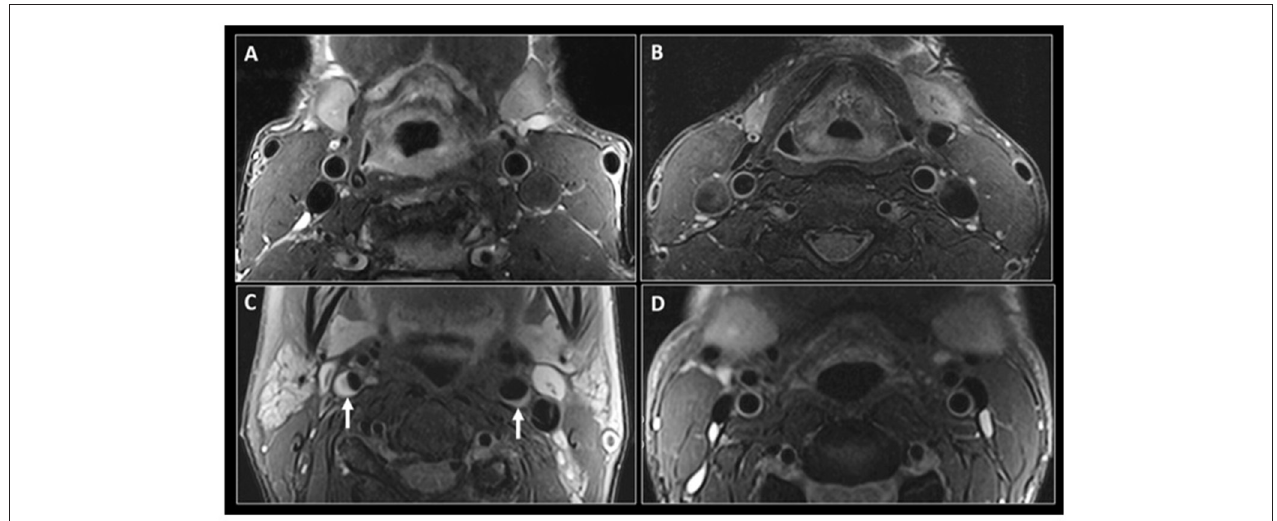
FIGURE 2 | Black-blood MR imaging of the carotid arteries. Adapted from “Subclinical atherosclerosis imaging in people living with HIV,” by I. C. Schoepf, R. R. Buechel, H. Kovari, D. A. Hammoud and P. E. Tarr, 2019, Journal of clinical medicine , 8(8), p. 1125 (https://www.mdpi.com/2077-0383/8/8/1125). CC BY. Fat saturated T2-weighted black-blood MR images at the level of the common carotid arteries in a 56-year-old HIV-positive man (A) and a 47-year-old HIV-negative man (B) . Similar imaging technique at the level of the internal carotid arteries in a 56-year-old HIV-positive woman (C) shows narrowing of the vascular lumen bilaterally by a plaque (small arrows), more significant on the right side. (D) shows similar imaging at the level of internal carotid arteries in a 47-year-old HIV-negative man with no evidence of